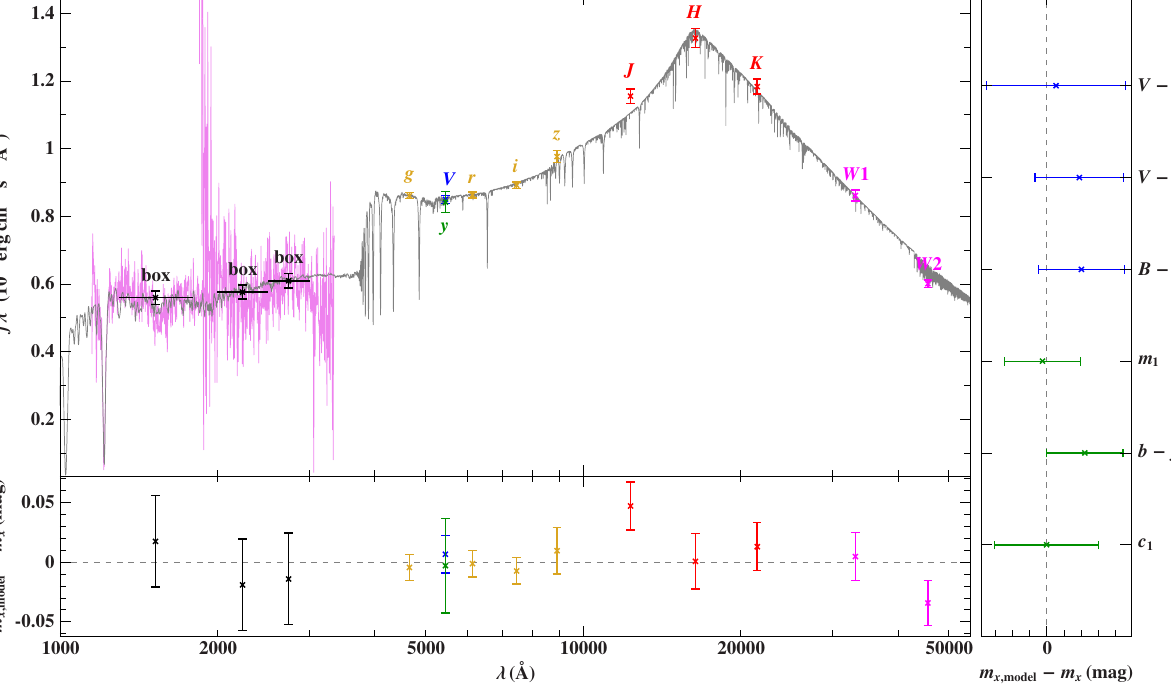
Figure 7. Same as Figure 6 but for the composite spectrum of PG0749+658. The bump in the H band is caused by the onset of H − absorp-